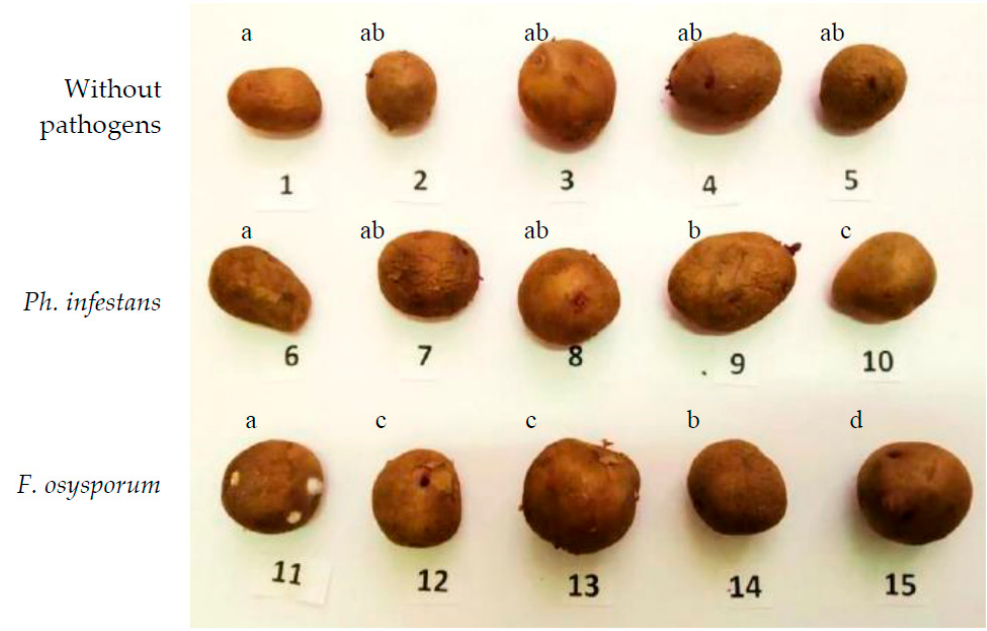
Figure 2. The effect of selected concentrations of B. subtilis 10-4 (10 8 CFU/mL) and 26D (10 8 CFU/mL) separately and compositions with SA ( B. subtilis 10-4 (10 7 CFU/mL) + SA; B. subtilis 26D (10 6 CFU/mL) + SA) on the development of F. oxysporum and Ph. infestans in potato tubers during storage (after 5 months storage). 1 —Control (without treatments); 2 —strain 26D; 3 —strain 10-4; 4 —strain 26D + SA; 5 —strain 10-4 + SA; 6 — Ph. infestans ; 7 — Ph. infestans +strain 26D; 8 — Ph. infestans +strain 10-4; 9 — Ph. infestans +strain 26D + SA, 10 — Ph. infestans +strain 10-4 + SA; 11 — F. oxysporum ; 12 — F. oxysporum +strain 26D; 13 — F. oxysporum +strain 10-4; 14 — F. oxysporum +strain 26D + SA; 15 — F. oxysporum +strain 10-4 + SA. In figure presented the pictures of medium tubers from five repetitions ± SEM. Different letters indicate a significant difference between the means at the probability level of p < 0.05.